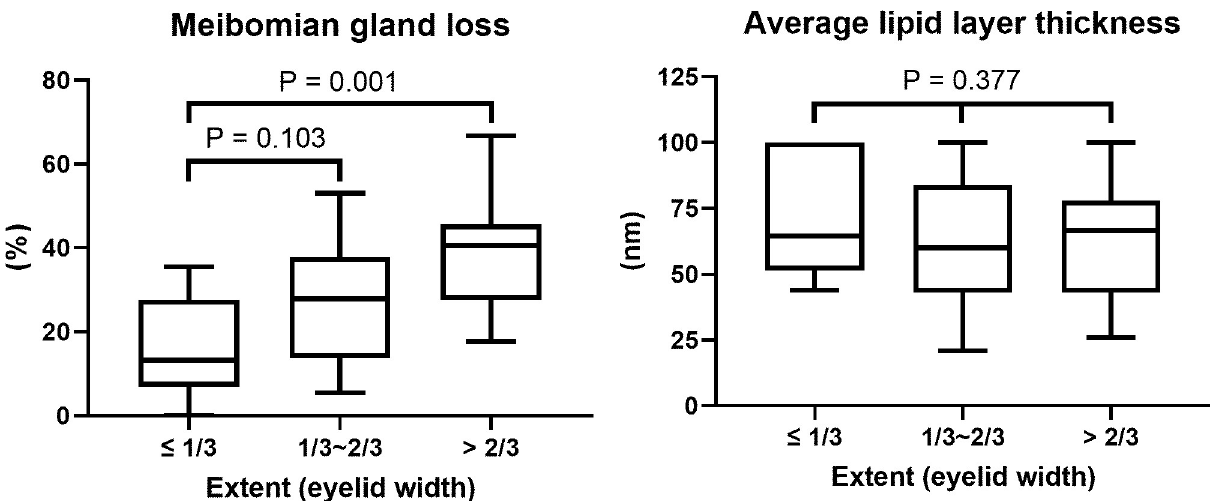
Fig 2. Box-and-whisker plots of meibomian gland loss and average lipid layer thickness according to entropion extent. Meibomian gland loss was significantly higher in eyes with entropion extent > 2/3 eyelid width than in eyes with entropion extent � 1/3 eyelid width (median 40.5% vs. 13.2%, P = 0.001, Dunn’s post hoc test with Bonferroni